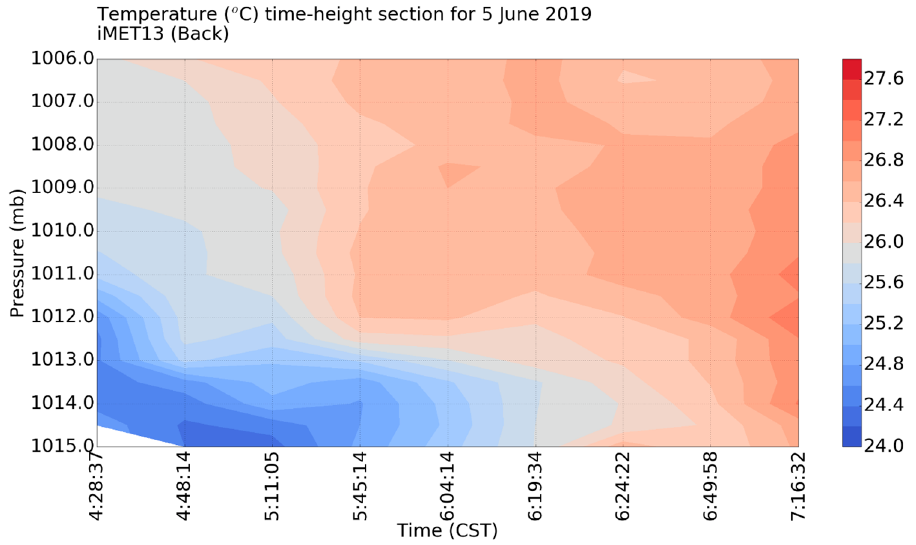
Figure 16. Time – pressure section of the temperature (°C) on the 5 June 2019 based on the nine soundings flown up to 122 m (400 ft) near the University of South Alabama campus in Mobile Alabama.